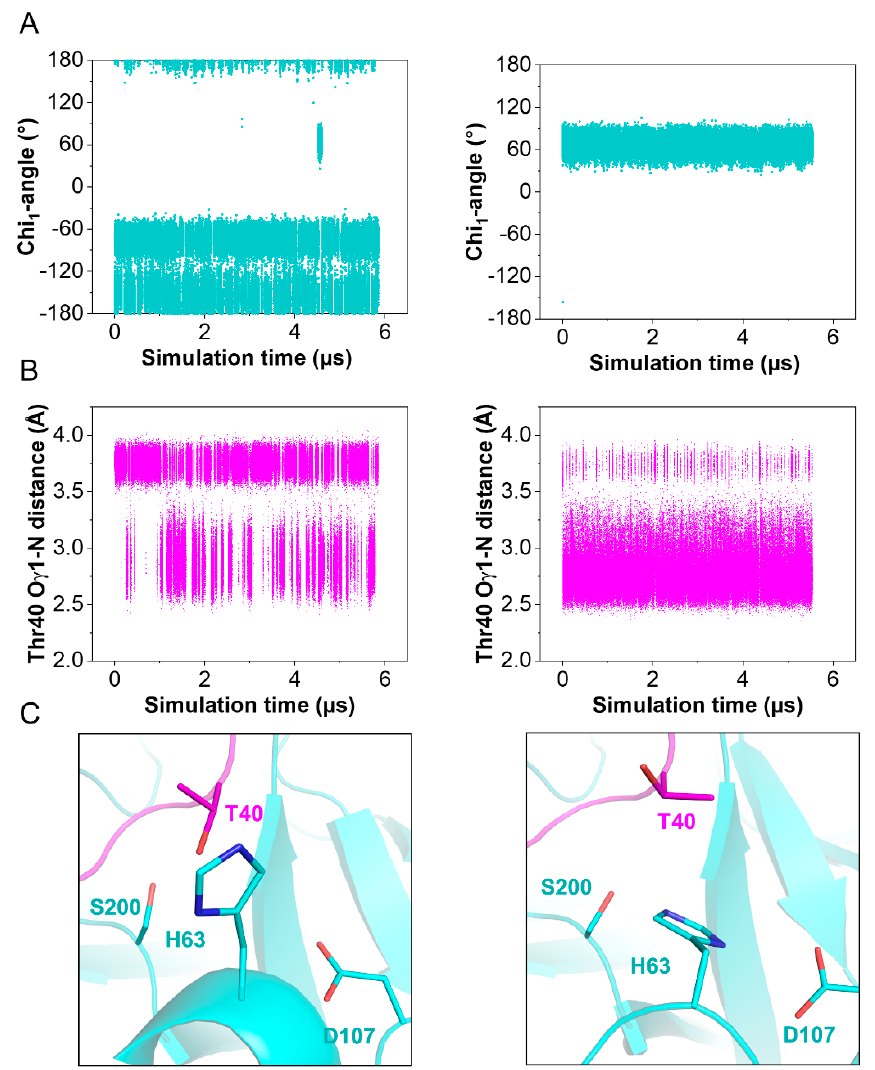
Figure 4. Observed His63 conformations during molecular dynamics simulations. Simulations started with His63 in either trans (Chi 1 = 180°) or gauche + (Chi 1 = − 60°) conformation ( left and right panel, respectively) ( A ) Chi 1 —angles of His63. ( B ) O γ 1—N distance of Thr40 in SPINK1. ( C ) Representative side chain conformations of Thr40 and